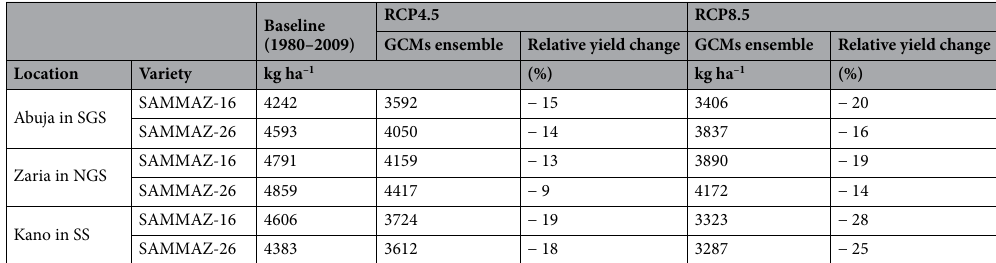
Table 5. Baseline and simulated grain yield (kg ha –1 ) of different maize varieties and the relative yield change (%) at mid-century in three agro-ecologies of Nigeria.